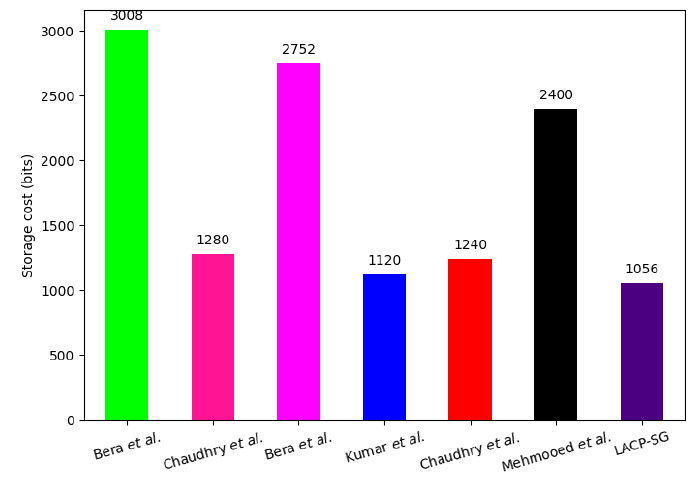
Figure 8. Total storage cost comparison